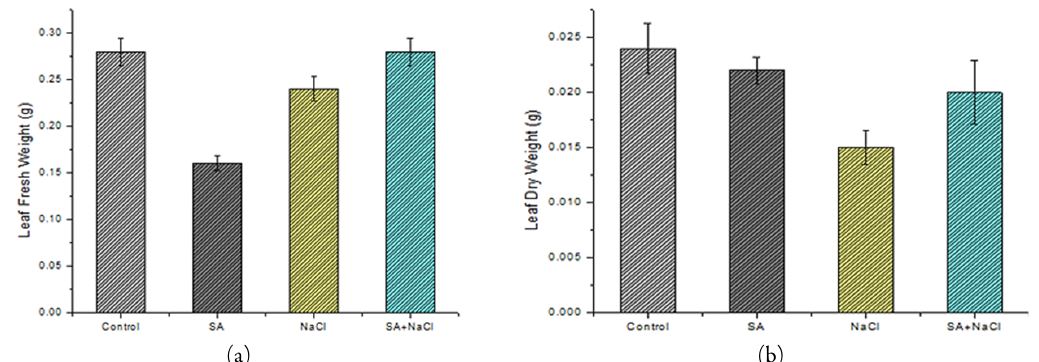
Figure 2. Leaf fresh weight (a) Leaf fresh weight of both individual and combined effect of salinity and SA. X axis-Treatment group; Y axis- fresh weight of leaves in gram. (b) Leaf dry weight of both individual and combined effect of salinity and SA. X axis-Treatment group; Y axis- Dry weight of leaves in gram Values are stated as mean ± SD, n=3 in each